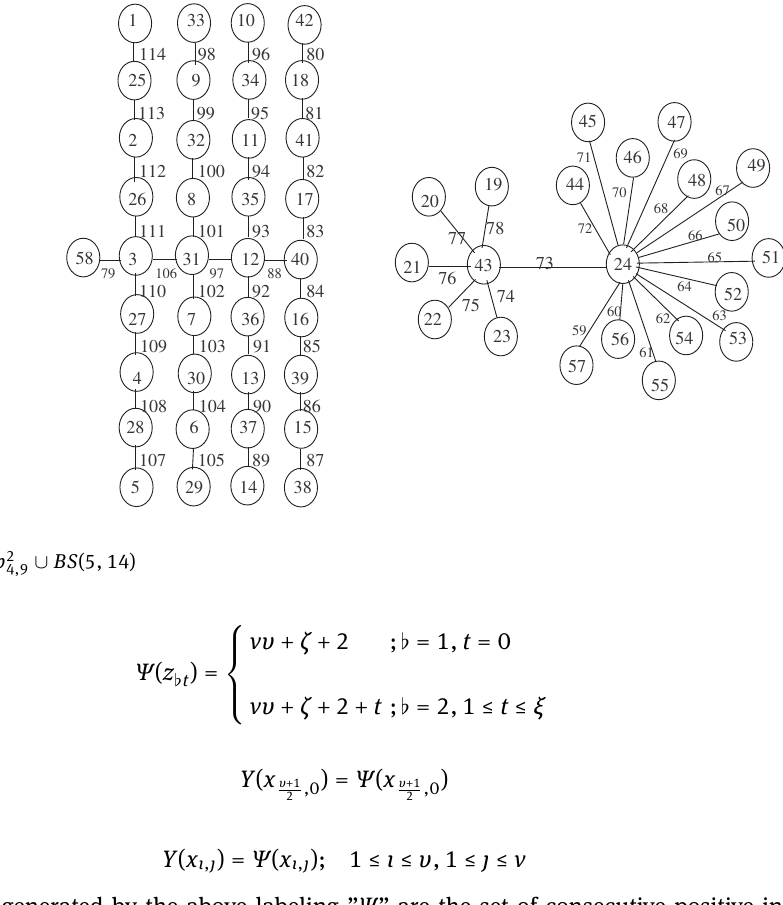
Figure 3: SEMT forest Cb 2 4,9 ∪ BS (5,